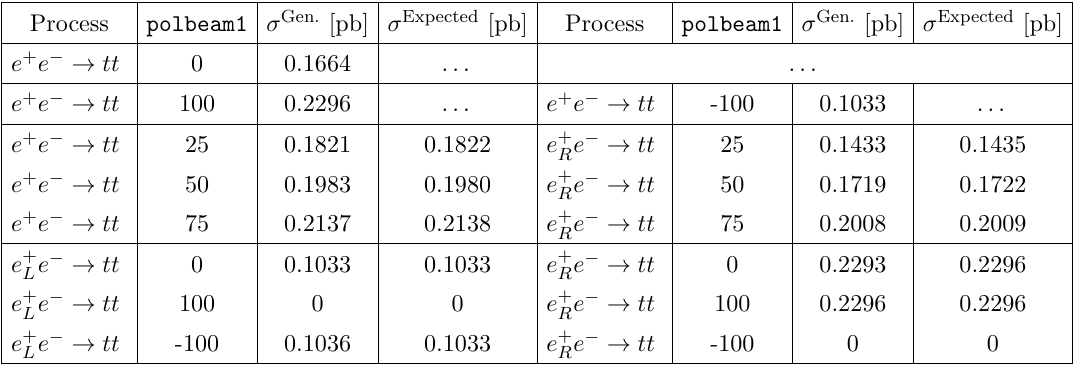
p s = 1000 GeV, assuming unpolarized